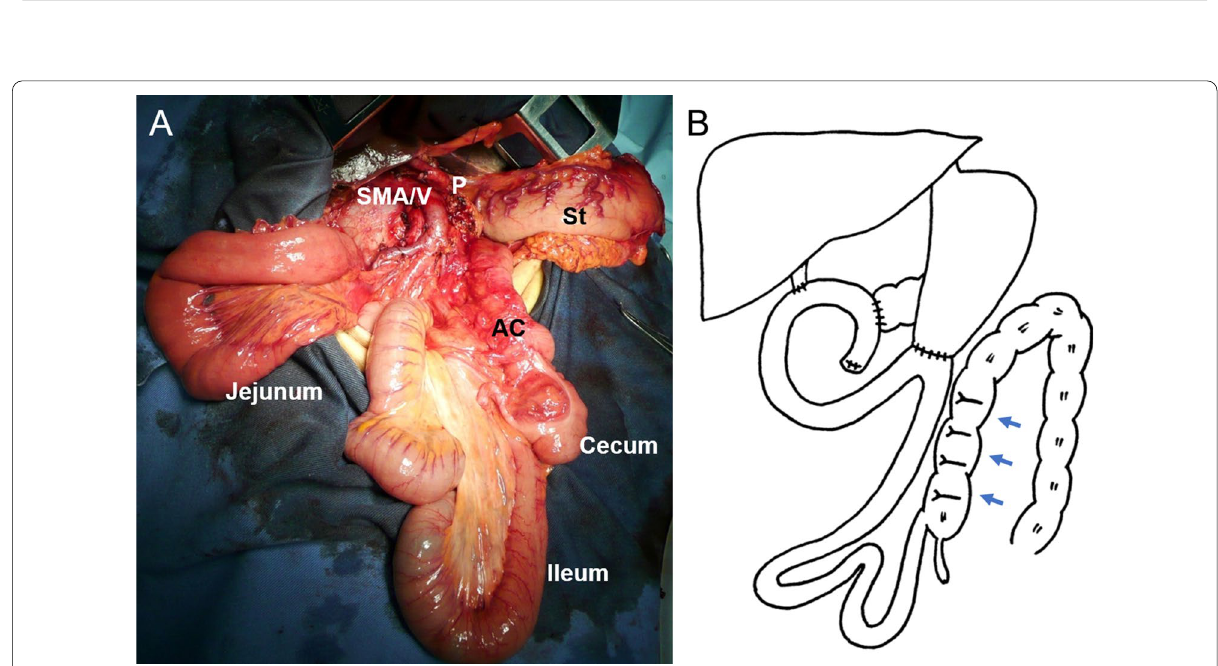
Fig. 2 Findings in the initial operation. a The ligament of Treitz was absent, and the small bowel was in the right abdomen. Further, the ascending colon and cecum were not fixed to the retroperitoneum but were located in the median abdomen. AC, ascending colon; P, pancreas; St, stomach; SMA/V, superior mesenteric artery and superior mesenteric vein. b Pancreaticoduodenectomy with reconstruction using the modified Child’s method was performed. We fixed the ascending colon to the abdominal wall because the ascending colon and efferent loop twisted easily